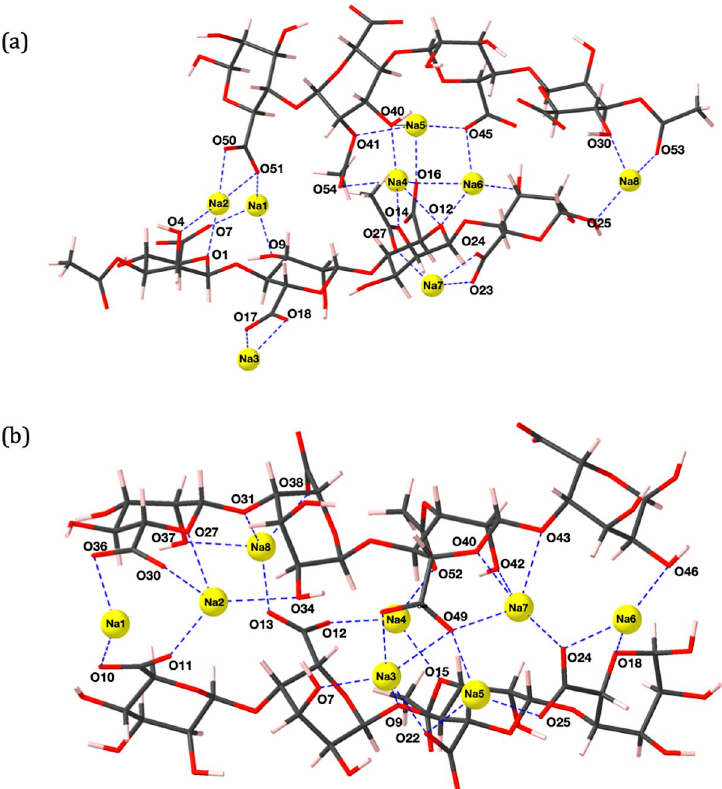
Fig 5. (a) PolyM (ap) (b) PolyMG (p) 2-chain sodium complexes. Carbon atoms are shown in grey, oxygen in red, sodium in yellow and hydrogen in pink. Oxygen atoms and cations involved in ionic bonding are labelled and the cation-oxygen bonds are shown with dashed blue